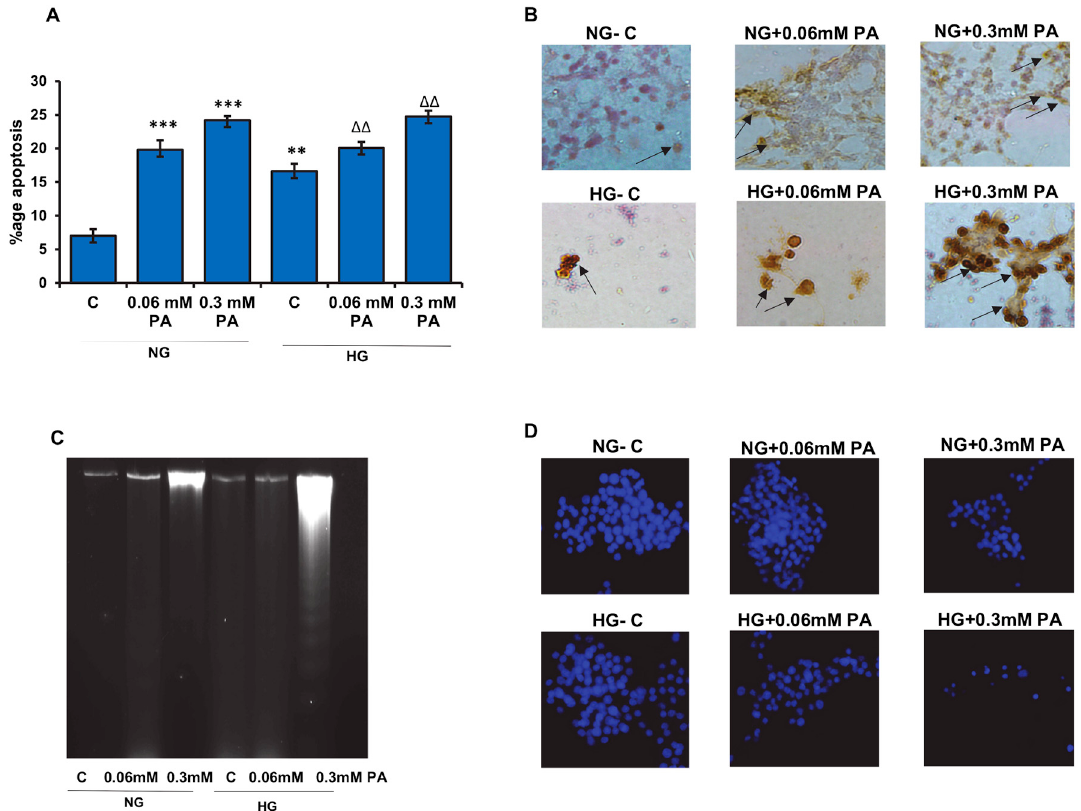
Figure 1. High glucose / high palmitic acid-induced apoptosis in Rin-5F cells. Apoptosis was measured in Rin-5F cells treated with di ff erent doses of palmitic acid (PA) under normal (NG) and high glucose (HG) conditions by flow cytometry ( A ). Percentage of apoptotic cells is represented as a histogram. In some cases, cells were grown on coverslips, and immunocytochemical localization of apoptosis (DNA fragmentation) was determined using the Apop Tag peroxidase in situ apoptosis detection kit, as per the manufacturer’s instructions. Some of the apoptotic nuclei are indicated with arrows ( B ). DNA fragmentation was also analyzed by agarose gel (2%) electrophoresis and ethidium bromide staining ( C ). Staining of nuclei of treated cells was also performed using Hoechst33342 dye ( D ) and analyzed by fluorescence microscopy. Cells with signs of apoptosis showed decrease in stained nuclei. Representative slides from three experiments are shown. Original magnification × 200. Asterisks indicate significant di ff erences (** p ≤ 0.01, *** p ≤ 0.001) relative to untreated control cells under normal glucose condition (NG-C), and triangles indicate significant di ff erences ( ∆∆ p ≤ 0.01) relative to untreated control cells under high glucose condition